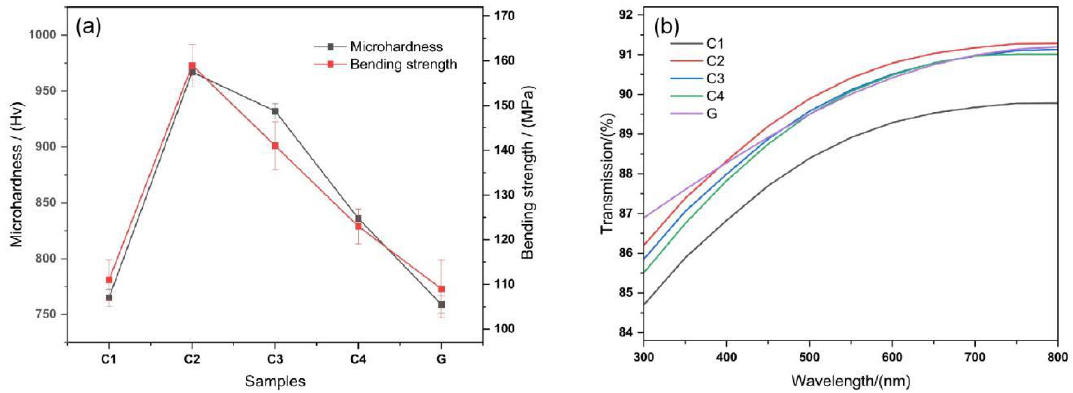
Figure 6. ( a ) Schematic of the flexural strength and microhardness of lithium aluminosilicate; ( b ) ble light transmission curve of lithium aluminosilicate visible light transmission curve of lithium aluminosilicate glass-ceramics.